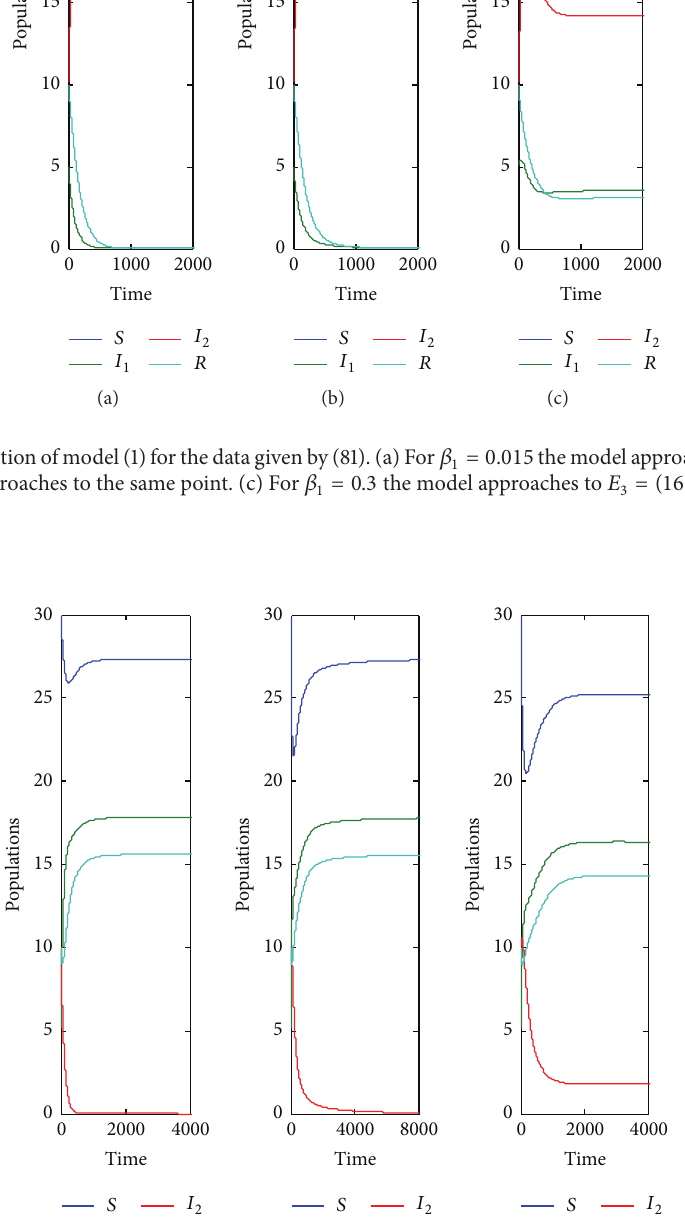
= 0.065 the model approaches to 𝐸 2